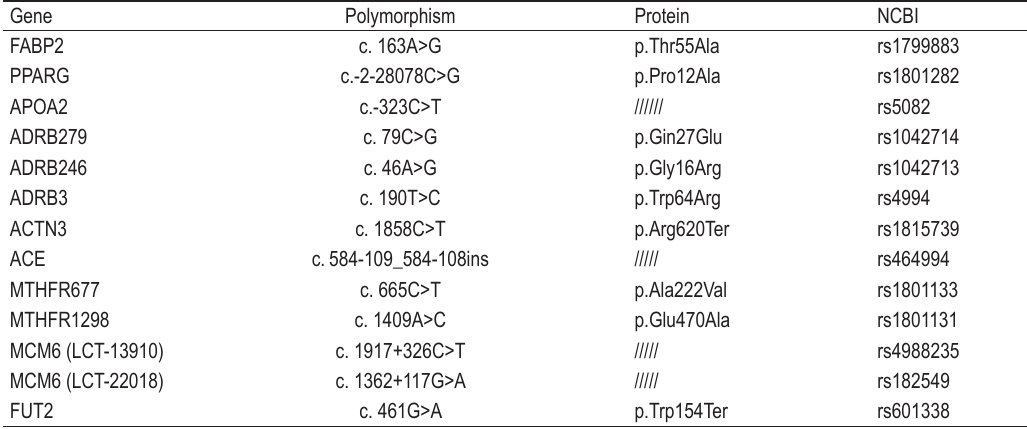
TABLE 1. List of polymorphisms of the genes related to diet and